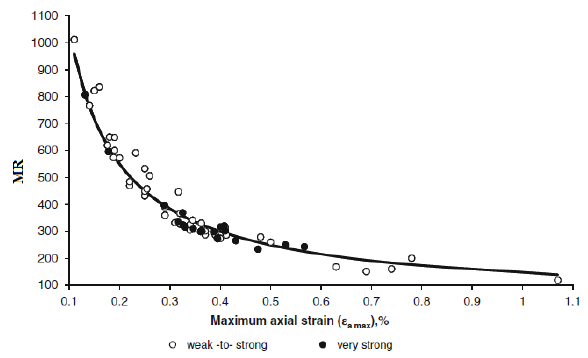
Fig. 2. Relationship between modulus ratio (M R ) and maximum axial strain ( a,max ) using different carbonate rocks (Palchik, 2011)